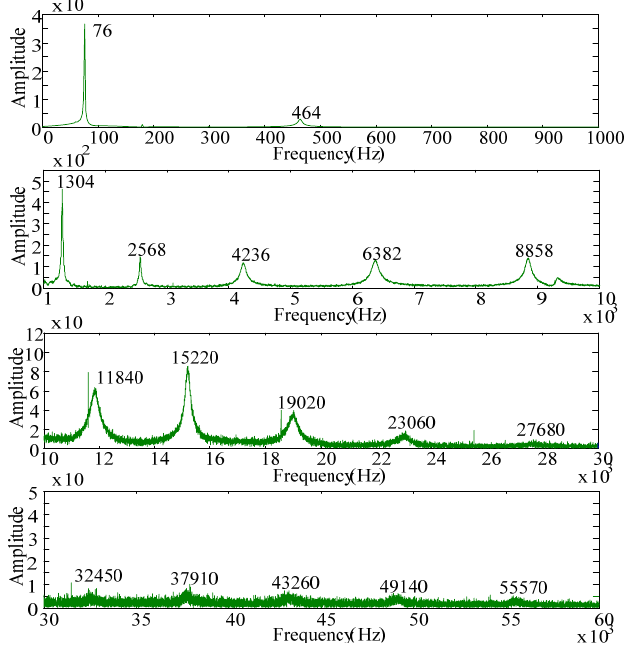
Figure 15. Frequency spectrum of PVDF 5 × 2.5 with impact on location